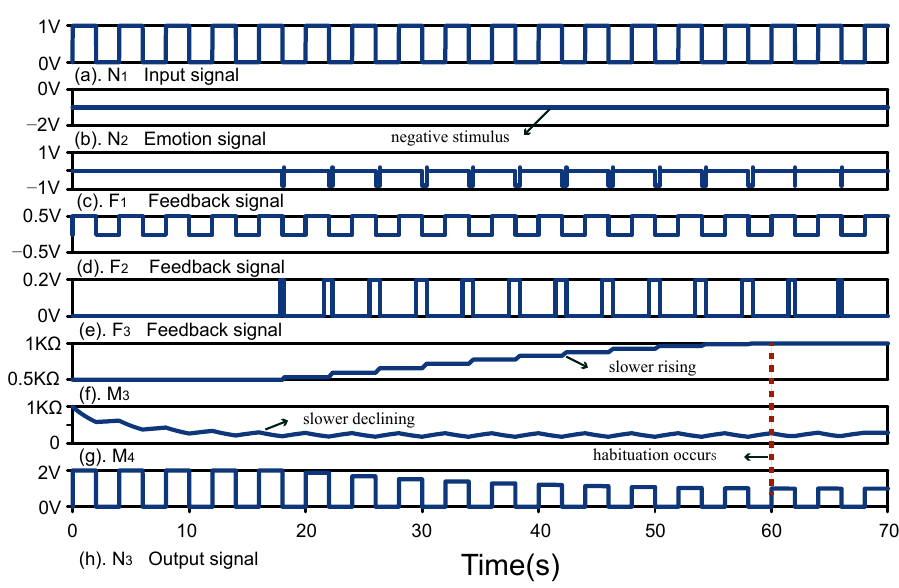
Figure 13. Habituation under negative stimulus. ( a ) Input signal. ( b ) Emotion signal. ( c ) Feedback signal F 1 . ( d ) Feedback signal F 2 . ( e ) Feedback signal F 3 . ( f ) Memristance of M 3 . ( g ) Memristance of M 4 . ( h ) Output signal N 3